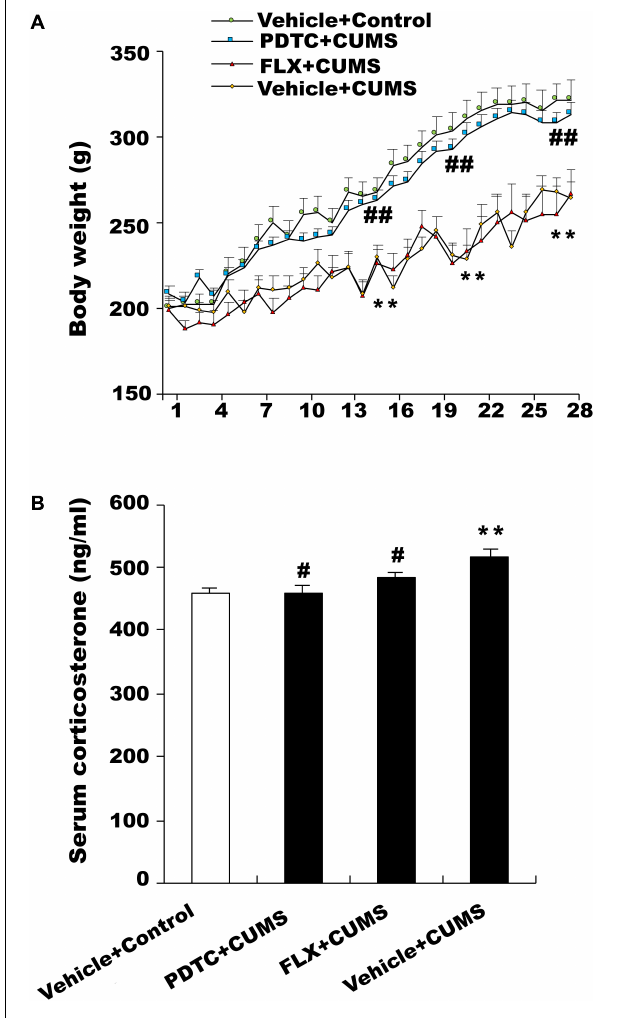
FIGURE 1 | Changes in body weight and serum corticosterone levels in response to chronic and unpredictable mild stress (CUMS). (A) Body weight in the CUMS group was significantly lower than in the control group. Pretreatment with pyrrolidine dithiocarbamate (PDTC), but not fluoxetine, reversed CUMS-induced weight loss. (B) CUMS rats showed an obviously higher level of serum CORT compared with the control group. PDTC and fluoxetine inhibited CUMS-induced increase in serum CORT. All values are presented as mean ± SEM. n = 10 and ∗∗ p < 0.01 versus the control group. # p < 0.05 and ## p < 0.01 versus the CUMS group. FLX,